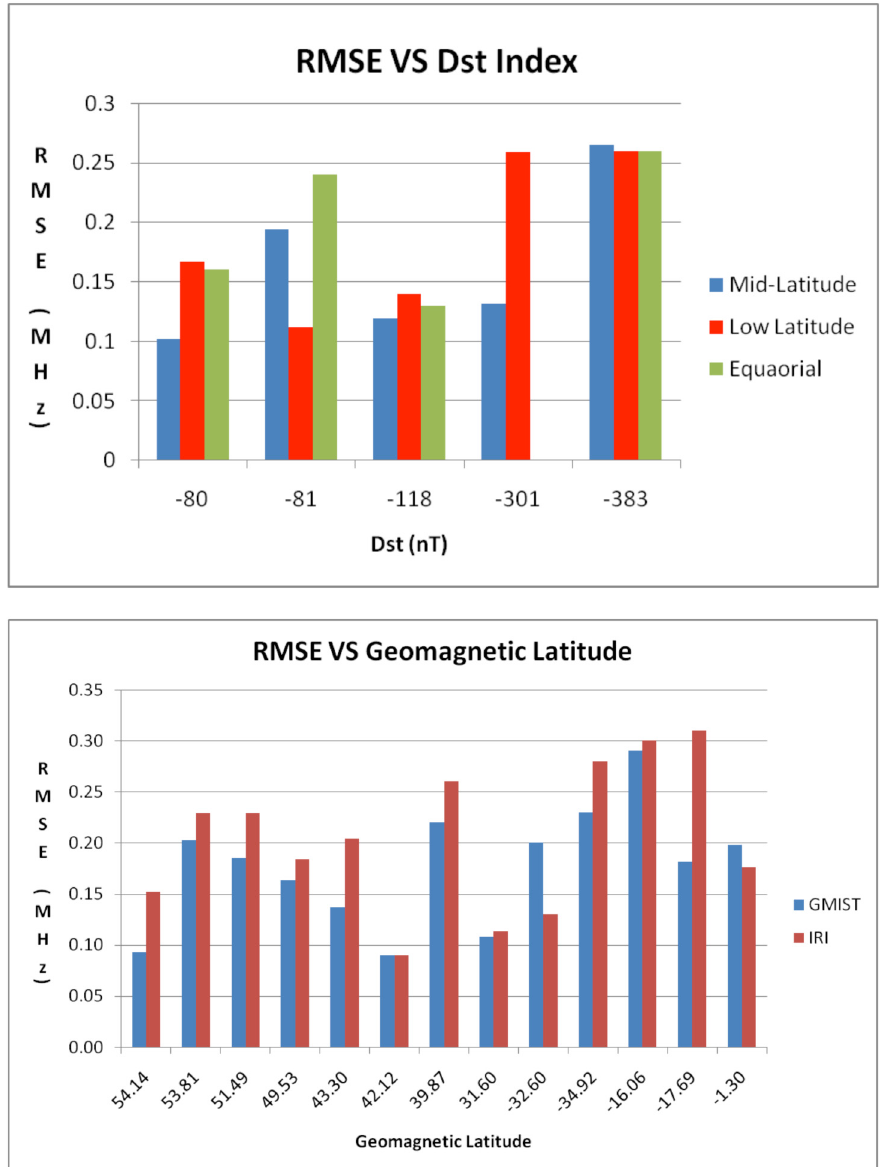
Figure 8. Effect of the maximum deviation of Dst index on RMSE for mid-, low-latitude and equatorial region (upper panel) and geomag- netic latitude variation of RMSE (bottom